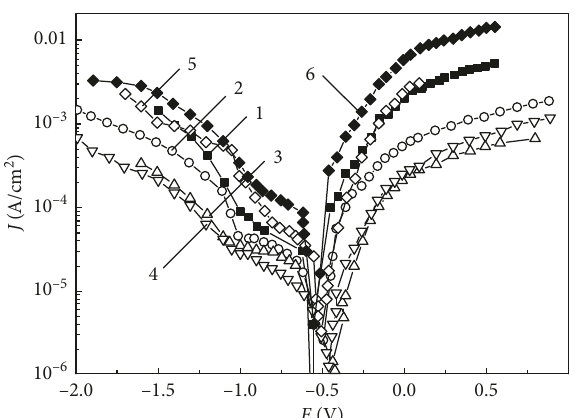
Figure 9: Polarization curves of 40Kh steel after normalization and the VCH (a working tool weight of 4.5kg) for different treatment times: (1) after normalization; (2) 6; (3) 12; (4) 20; (5) 28; (6)